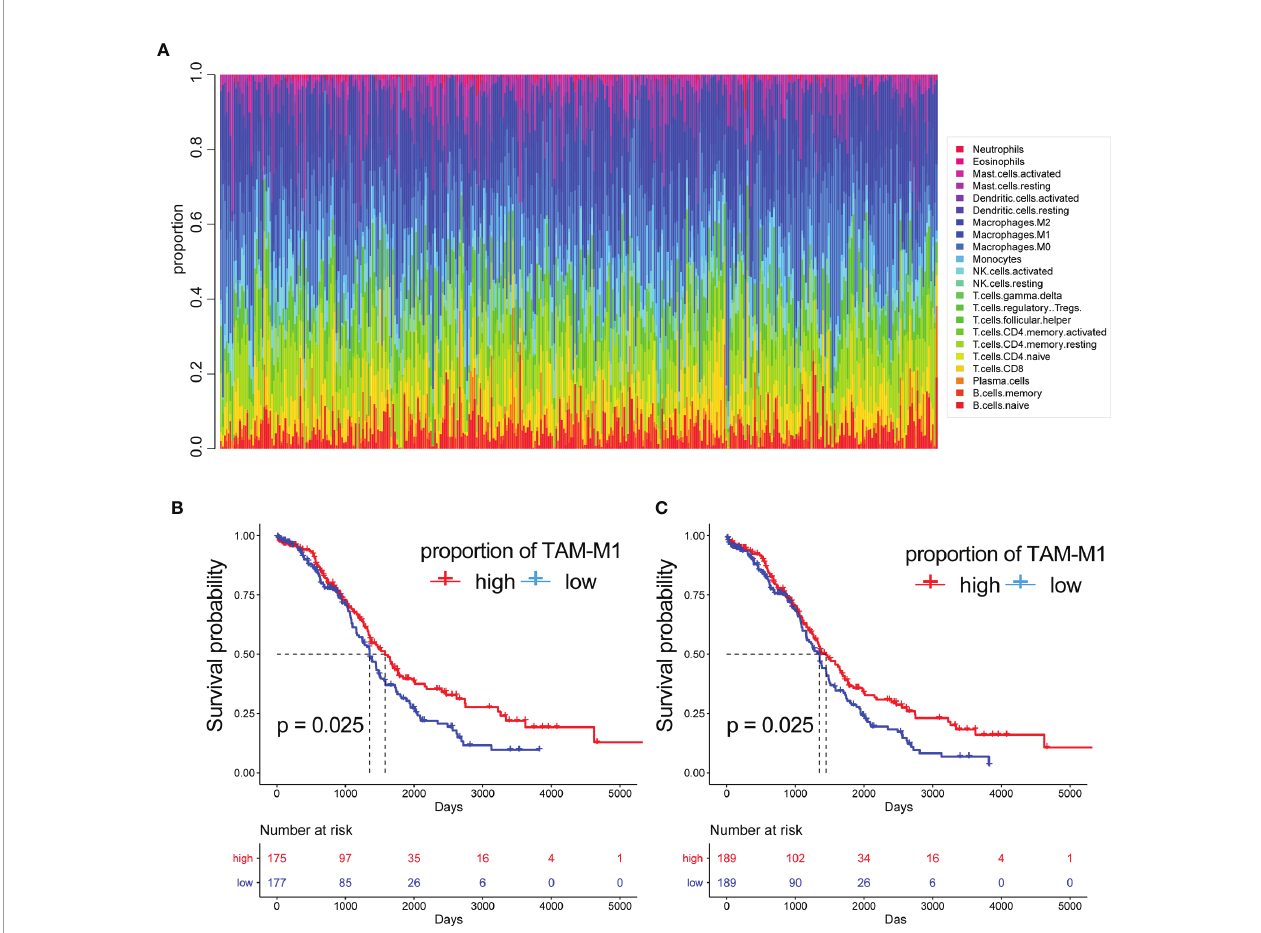
FIGURE 4 | The proportion of immune cells. (A) The proportion of 22 immune cells built on RNA-seq count data. The Kaplan-Meier curves of patients with different proportions of M1-like myeloid cells: (B) are disease free interval (DFI) (C) overall survival